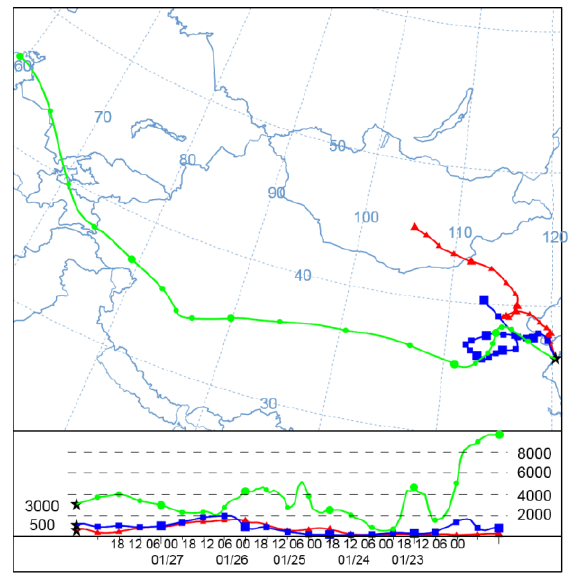
Figure 5. Source directions of typical precipitation air masses during the sampling periods.